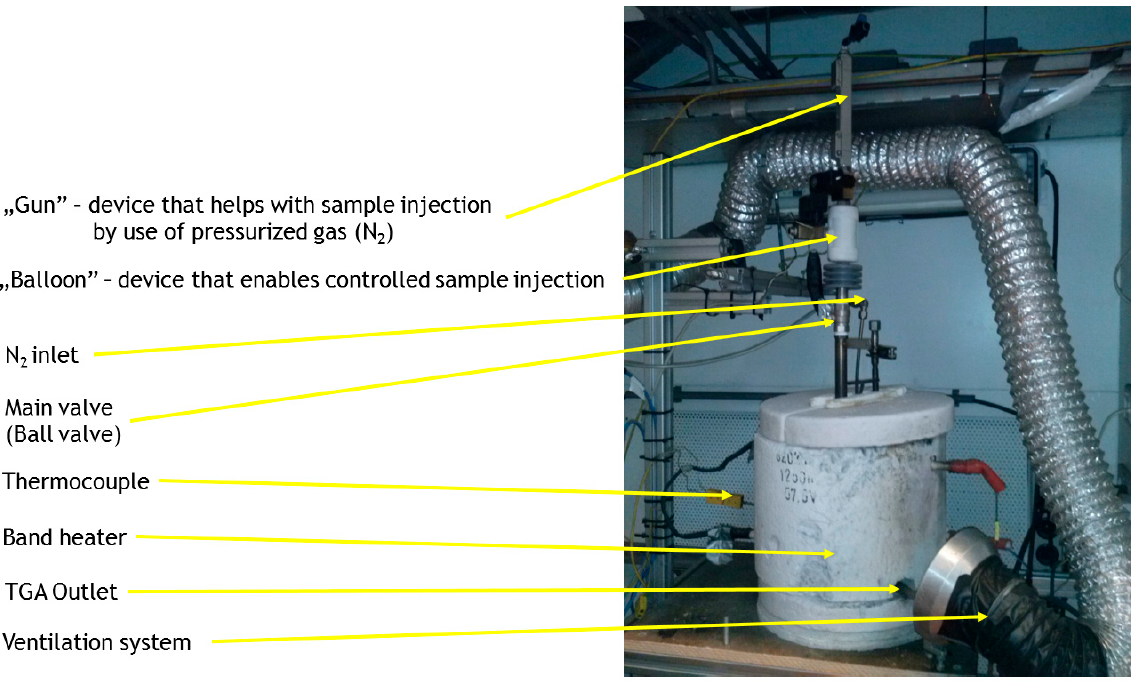
Figure 2. Cyclonic TGA.